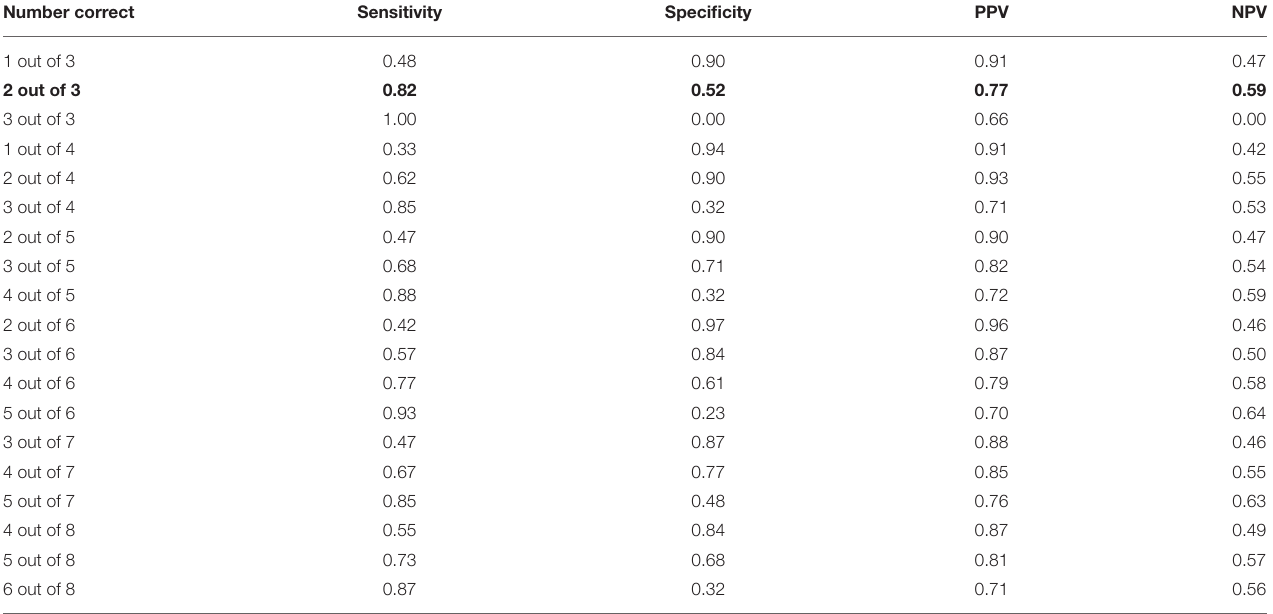
TABLE 3 | Binary classification results for odorant combinations for freezers vs. non-freezers. Number